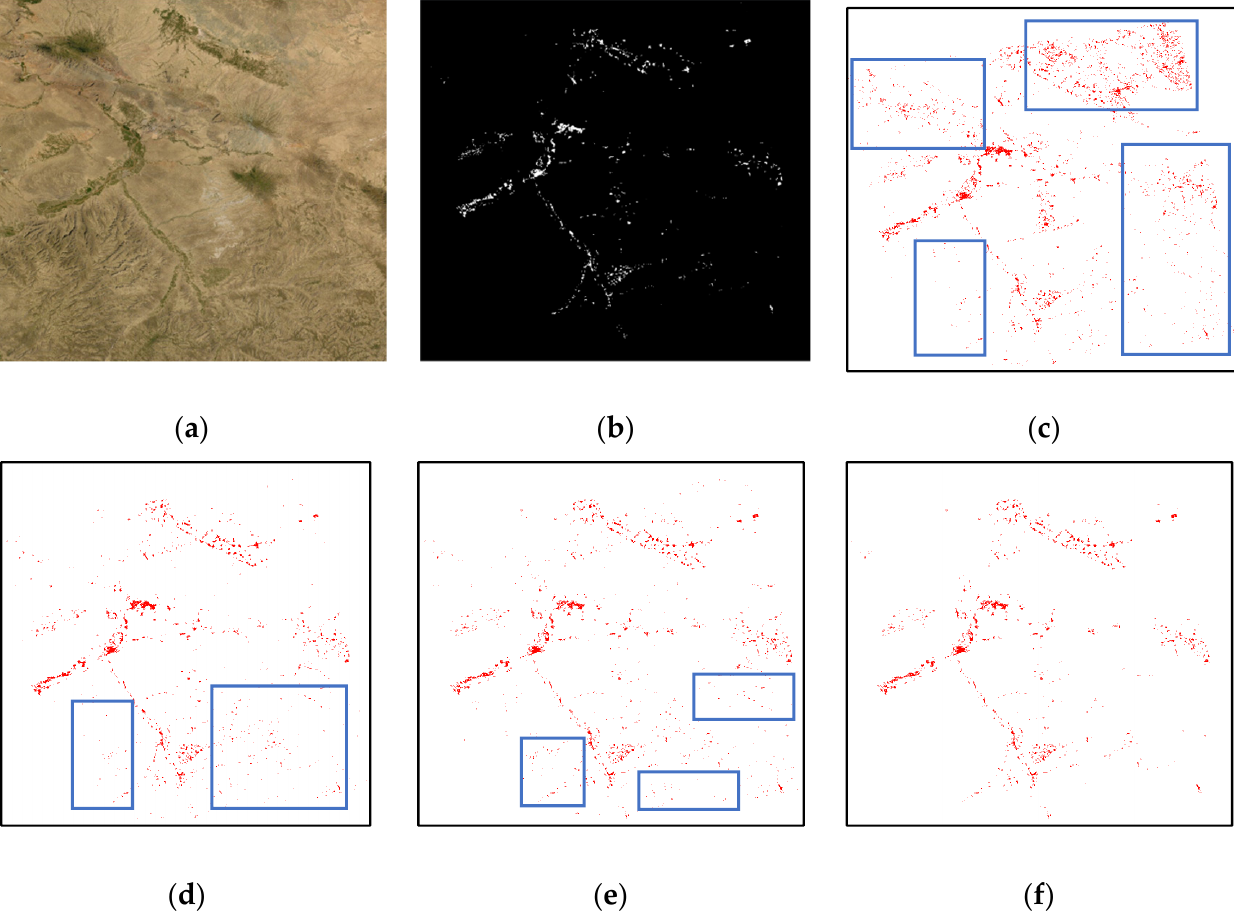
Figure 8. The BA results in T1: ( a ) Google Earth image, ( b ) ground truth, and ( c – f ) results based on UNet, PSPNet, SegFormer, and the proposed model. The blue box marks the false alarms.